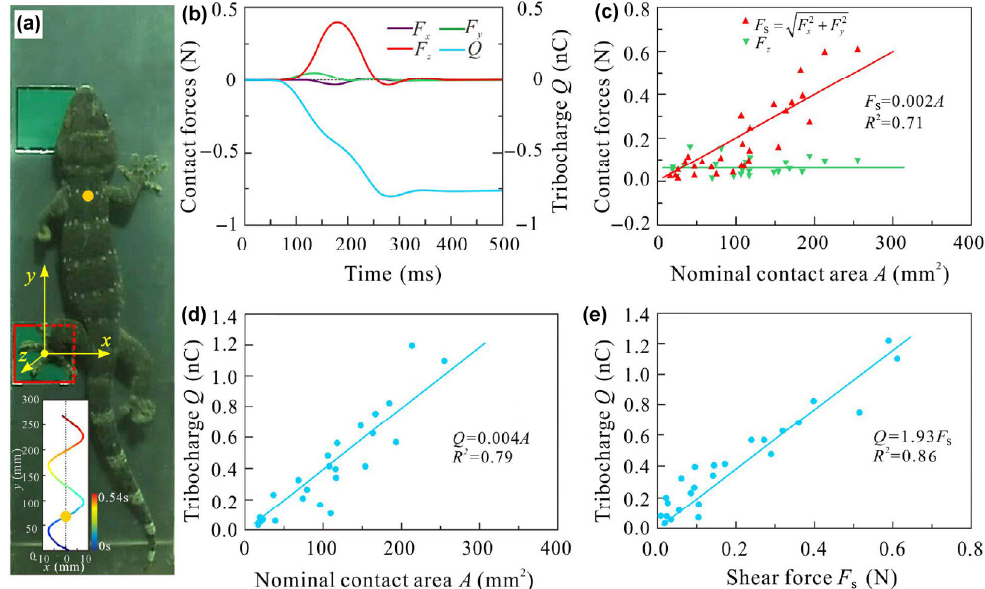
Fig. 4 Experiment results. (a) An illustration of the interaction between a gecko’s foot and the insulator film; insert, the trace of the middle point of the gecko’s front shoulders. (b) Typical test results. (c) The relationship between nominal contact areas and forces. (d) The relationship between a contact area and tribocharge. (e) The relationship between tribocharge and contact forces. The data are obtained from the left hind feet, and therefore the normal forces are